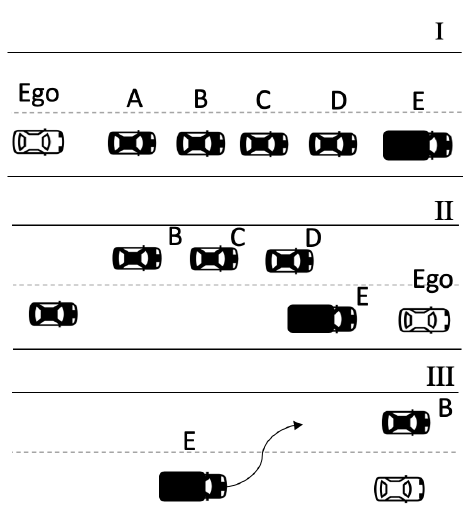
Figure 6. Traffic definition in the rain (machine uncertain-human certain condition (MU-HC)) scenarios. Five vehicles were driving on the right lane at 80 km/h, spaced 250 m apart (I). The ego-vehicle could maintain the target speed (120 km/h) by overtaking the vehicles. When the front truck (E) was overtaken, a trigger point was activated that made the trailing cars B, C, and D switch to the left lane, and adjust their speed to 160 km/h (II). This resulted in B, C and D eventually overtaking the ego-vehicle from the rear. When D passed the ego-vehicle (III), the leading vehicle (A) accelerated to 160 km/h, and it changed to the left lane if it came within a distance of 30 m of the